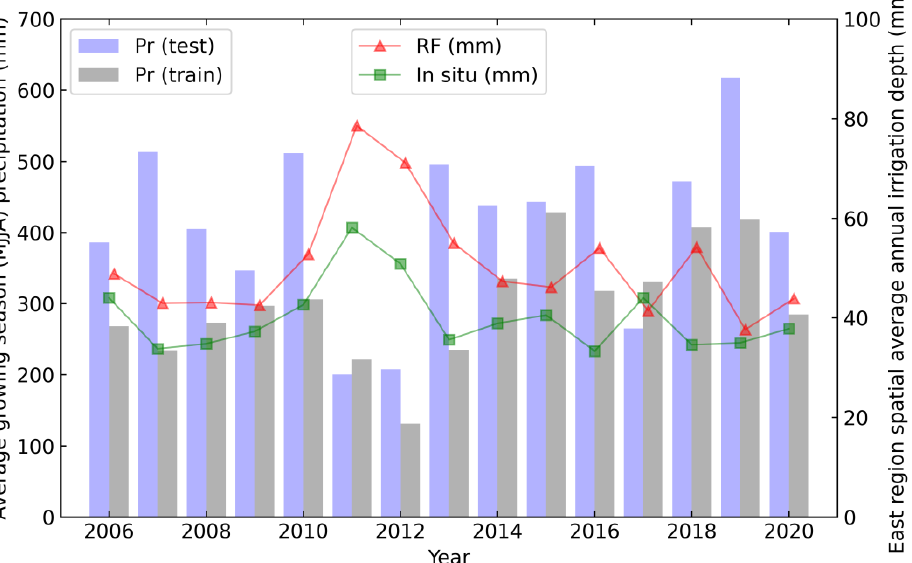
Figure 5. Annual irrigation amounts from the RFR (red triangles) and in situ records (green squares) for the test data (eastern portion of Kansas HPA) in Experiment B (spatial split). The growing season (May, June, July, August, MJJA) total precipitations for training (grey bars) and test (purple bars) portions, respectively, are also shown.